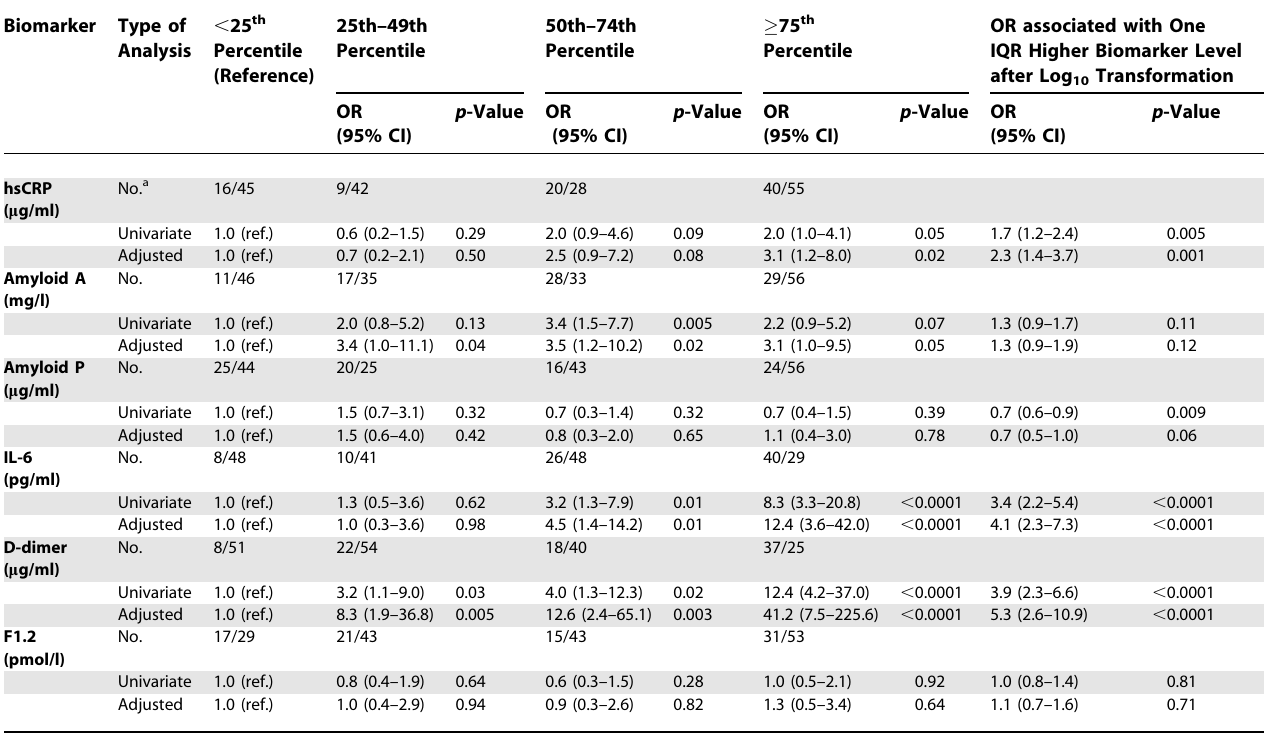
Odds ratios are derived from separate conditional logistic models for each biomarker (two unadjusted-univariate and two adjusted models for each biomarker, one with quartiles and one with continuous level of biomarker after log 10 transformation); adjusted models include age, race, use of ART and HIV-RNA level, CD4 þ cell count, smoking status, BMI, prior CVD, diabetes, use of BP medication, use of lipid-lowering medication, total/HDL cholesterol, co-infection with hepatitis B or C, and treatment group. Percentile definitions are based on the random sample of 499 participants (see Figure 2). Percentile cut-off points (IQR on log 10 scale) are hsCRP: , 0.93, 0.93–2.29, 2.30–4.69, (cid:4) 4.70 (0.71); amyloid A: , 2.0, 2.0–3.4, 3.5–6.3, (cid:4) 6.4 (0.50); amyloid P: , 49, 49–60, 61–80, 81 (0.22); IL-6: , 1.6, 1.6–2.3, 2.4–3.8, (cid:4) 3.9 (0.39); D-dimer: , 0.18, 0.18–0.33, 0.34–0.63, (cid:4) 0.64 (0.58); F1.2: , 225, 225–319, 320–464, (cid:4) 465 (0.32). a No. is number of